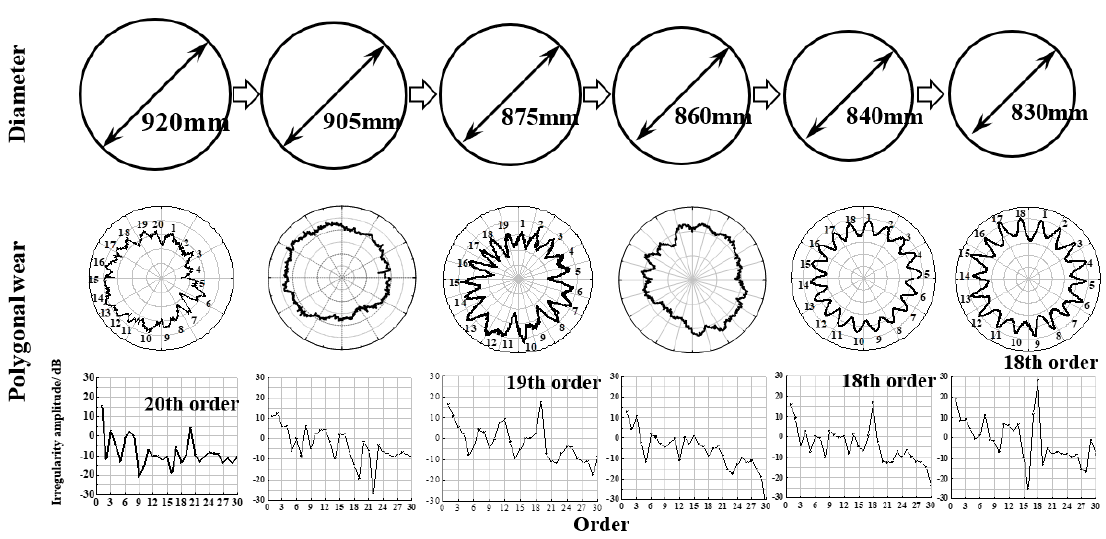
Table 1. Parameter values of the vehicle and track subsystem.